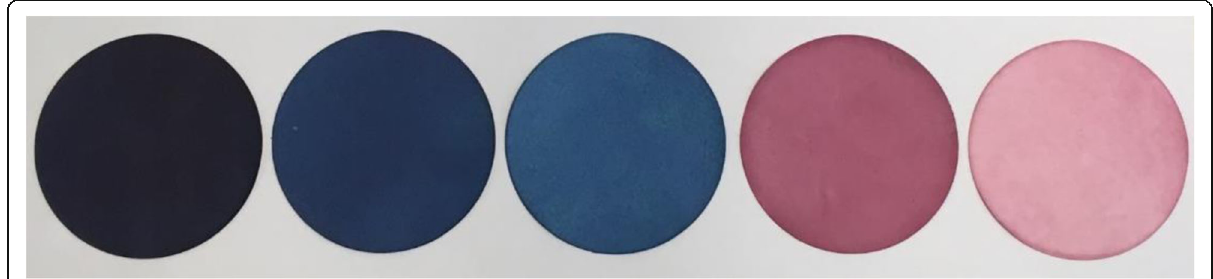
Fig. 10 Photographs showing the color changes of probe 1 upon immersing in different concentration of Ag + in HEPES solution (from left to right: 0.00, 0.05, 0.10, 0.50, 1.00 μ